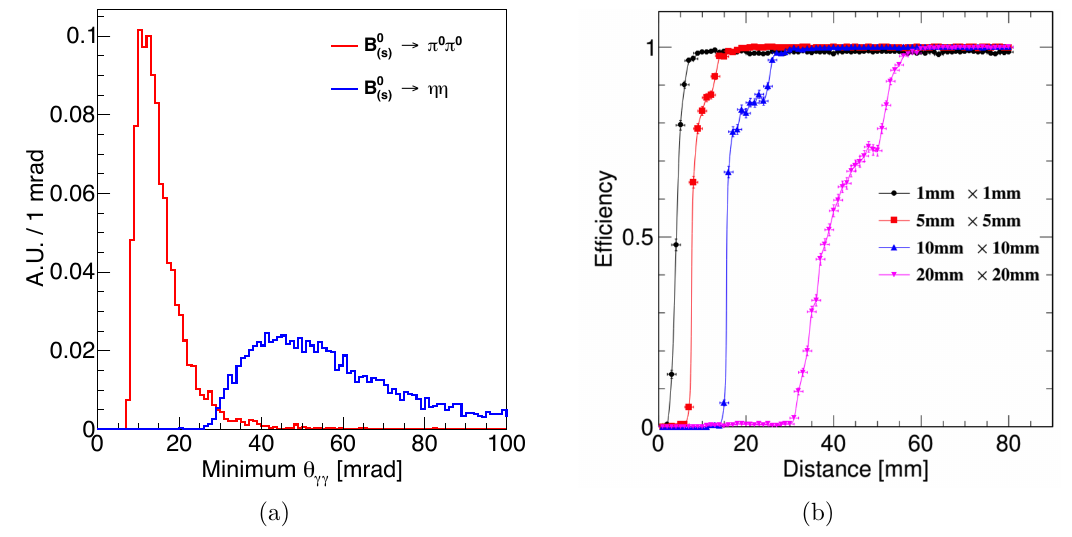
Figure 9 . (a) Distribution of the minimum opening angle among four photons from B 0 and B 0 → ηη . (b) Reconstruction efficiency of two parallel 5 GeV photons as a function of their ( s ) separation distance with different ECAL sensor sizes. The blue curve corresponds to the CEPC baseline ECAL